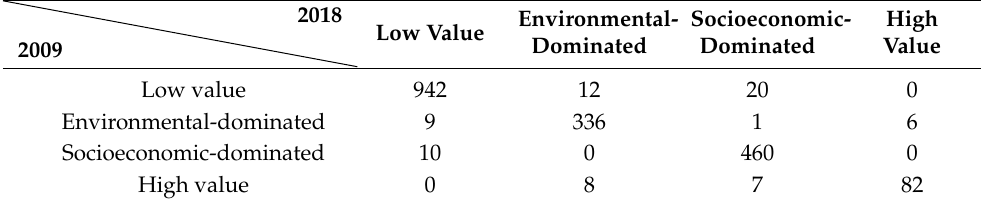
Table 4. Type transfer matrix of townships from 2009 to 2018.